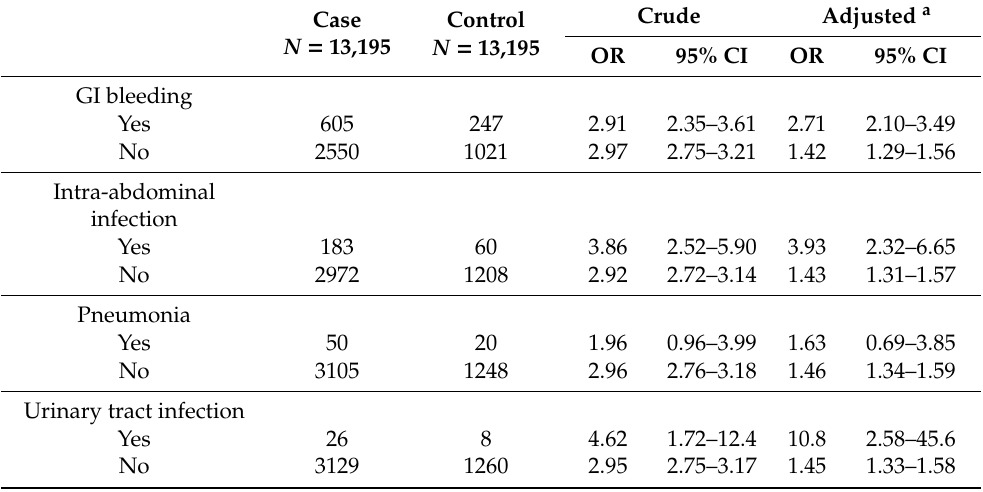
Table 4. Hepatic encephalopathy risk associated with proton pump inhibitor for a 28-day window period stratified by current medical